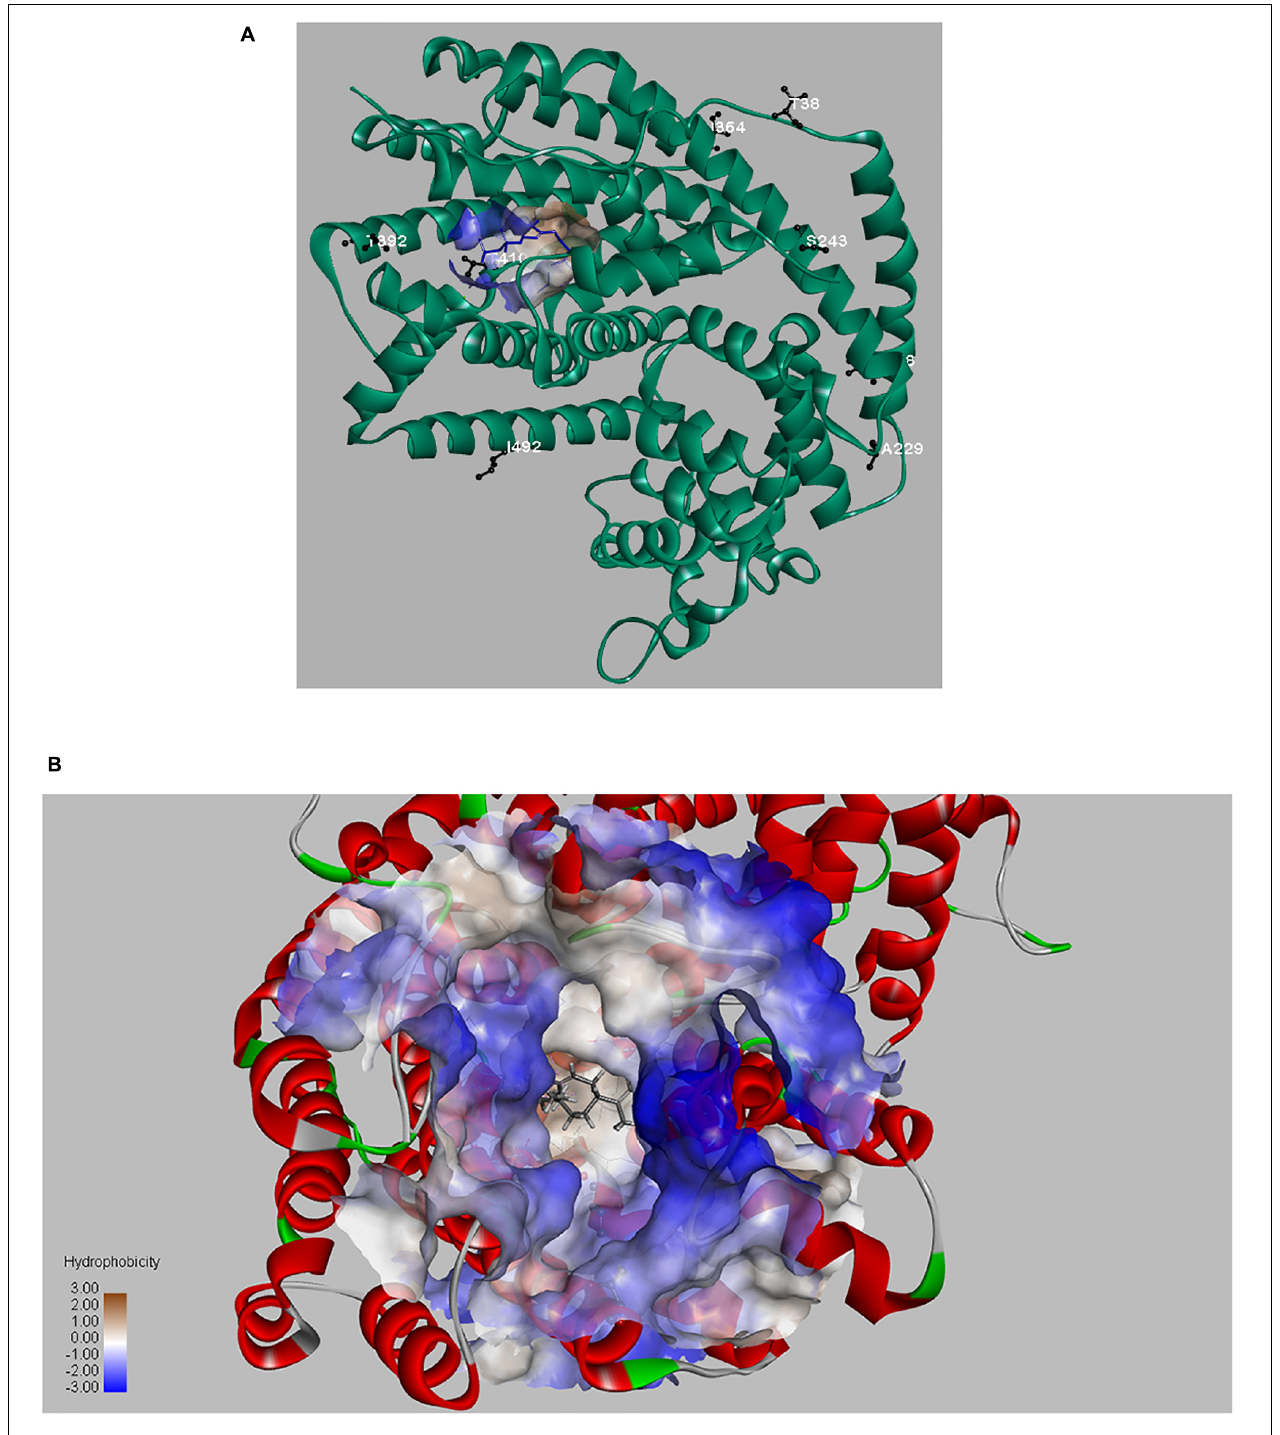
FIGURE 8 | The overview structure of LTC2 and mutant residues (A) ; LTC2-FPP interaction and active channel (B) .